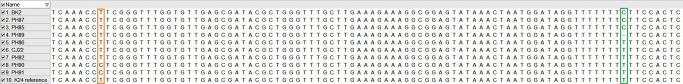
Partial sequence of nine C. metapsilosis clinical isolates and reference strain.(amplicon position 141 bp and 218 bp highlighted)